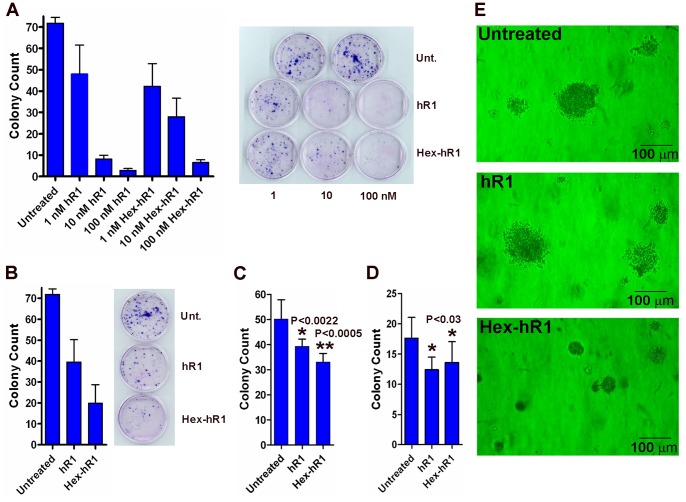
Inhibition of colony formation of DU 145 in monolayer culture with continuous (A) or single exposure (B) to hR1 or Hex-hR1 at 1, 10, and 100 nM;
inhibition of anchorage-independent growth of ACHN (C) and 786-O (D) by hR1 and Hex-hR1 in soft agar; (E) representative images of the colonies formed by cells treated or not with hR1 or Hex-hR1.